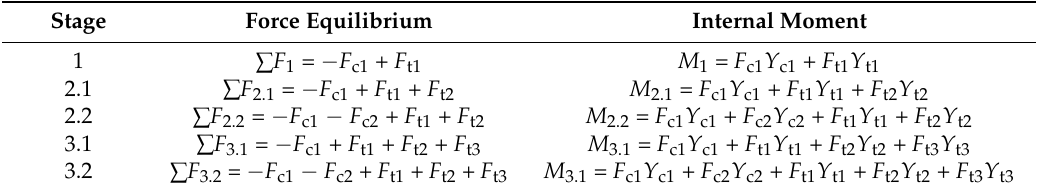
Table 2. Equilibrium of the force and the internal moment for each stage of applied strain at the most tensile bottom fiber ( β